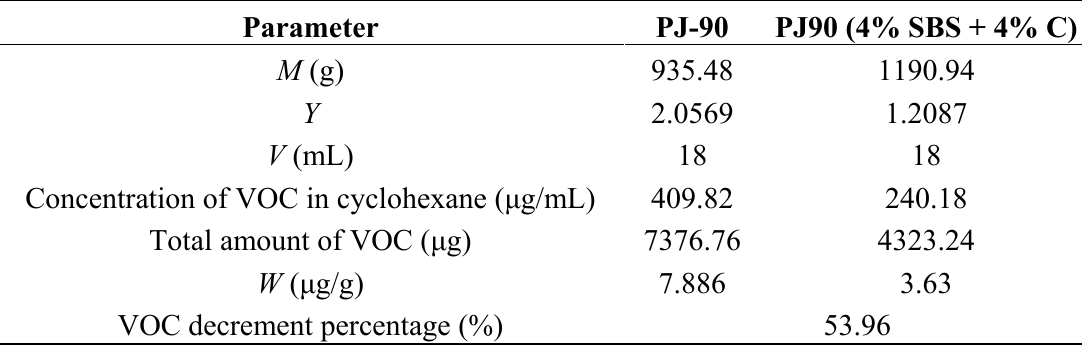
Table 5. Quantity values of VOC emission from bituminous materials.